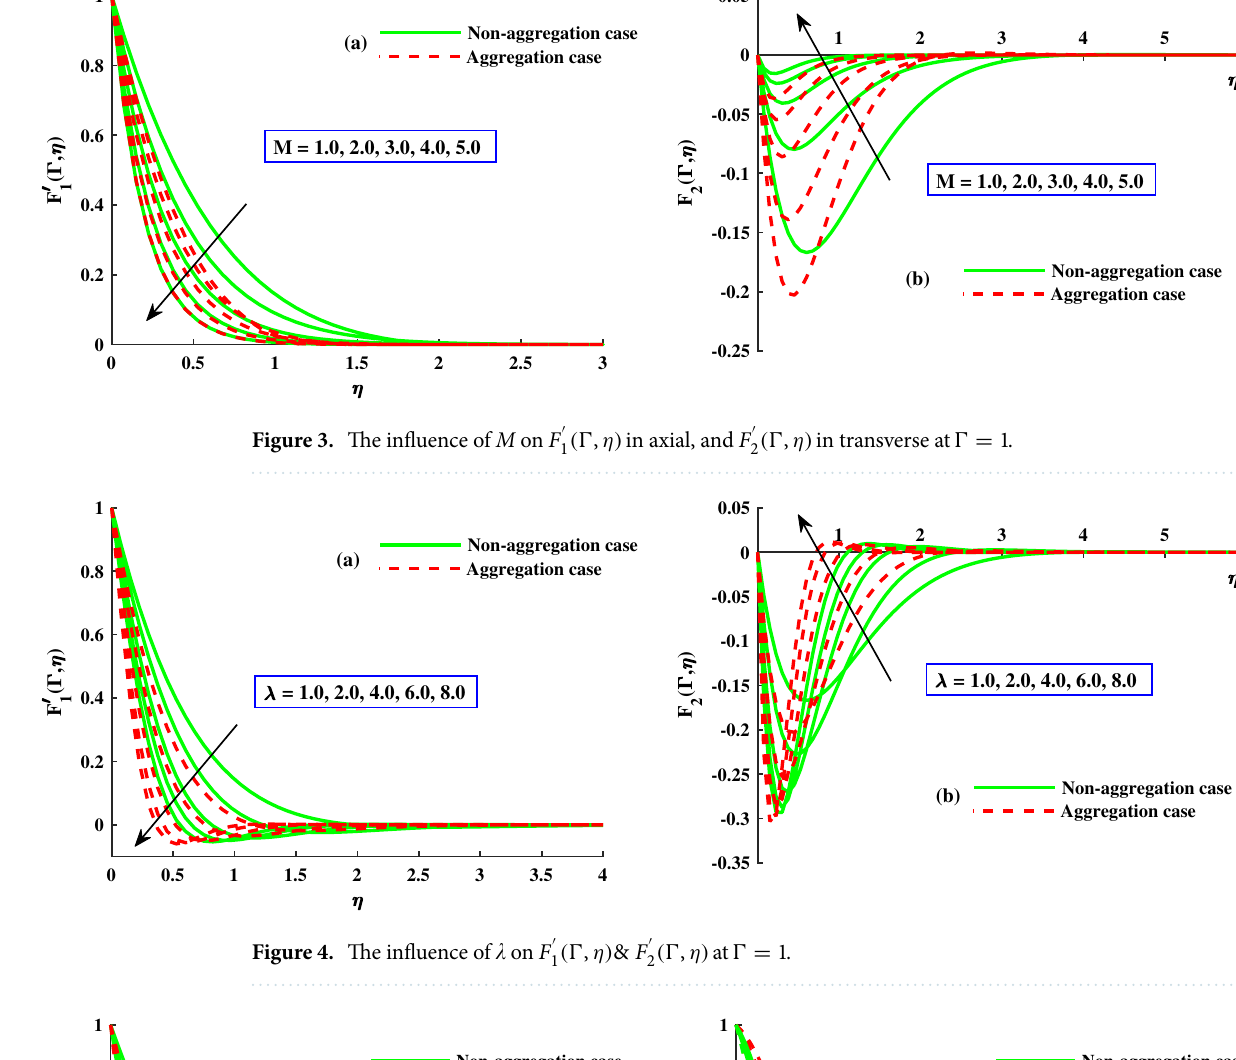
Figure 4. The influence of (cid:31) on F ′ 1 (Ŵ , η) & F ′ 2 (Ŵ , η) at Ŵ